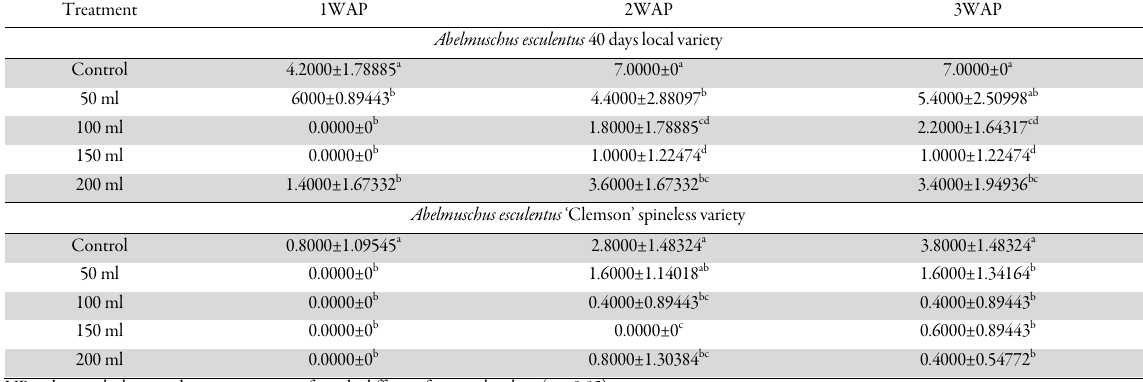
Table 2. Germination count and number of surviving seedlings as affected by different concentrations of spent engine oil Treatment